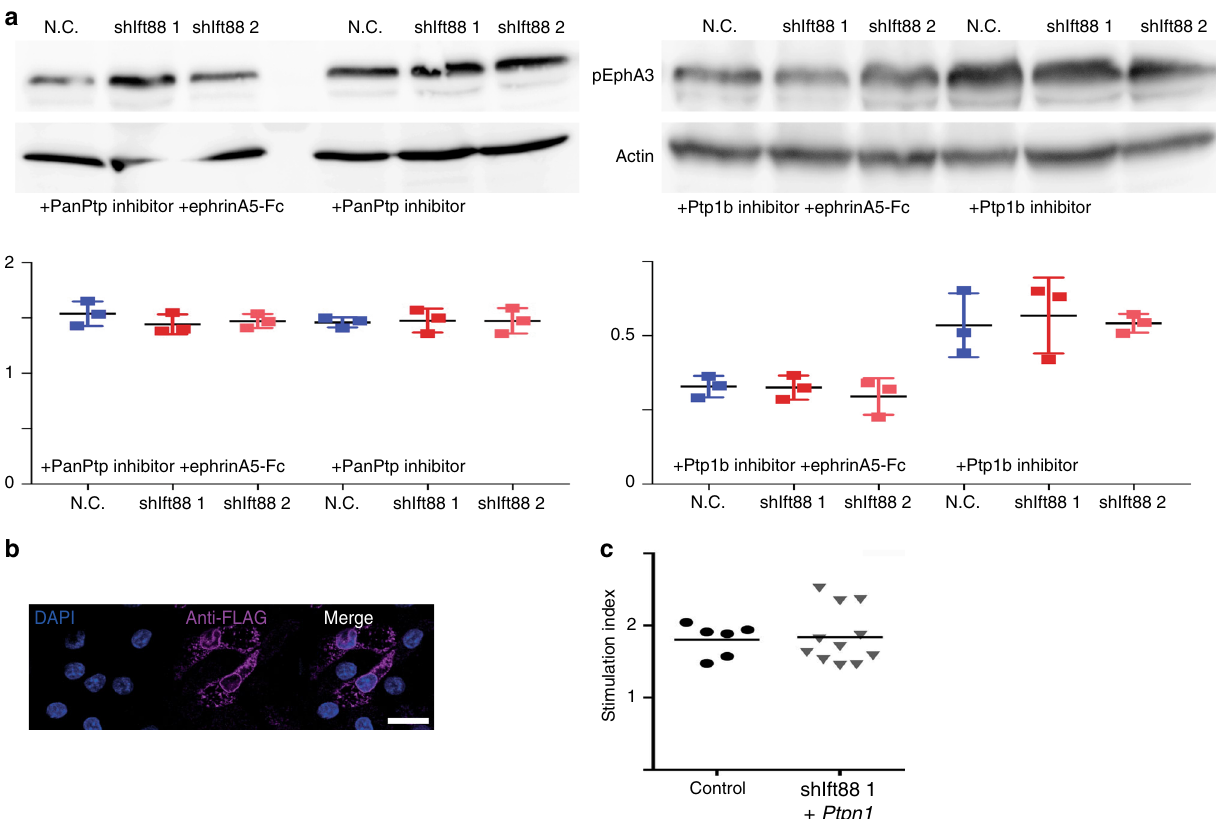
Fig. 5 Ciliary dysfunction impairs phosphatase activity. a pEphA3 (Tyr779) and actin levels in shIft88 1 and 2 and control cells treated with CinnGEL 2- methylester (Ptp1b-speci fi c inhibitor) or PTP inhibitor II in absence or presence of 1 μ g ml − 1 EphrinA5-Fc with quanti fi cations, mean ± s.d. b Localization of Flag-tagged PTP1B (magenta) in MIN6m9 cells (scale bar 20 µ m). c Insulin secretion of shIft88 expressing MIN6m9 cells transfected with Ptpn1 (2 μ g plasmid per well) ( n = 6 control, 12 shIft88 experiments, insulin measured n = 2 per experiment, mean ±